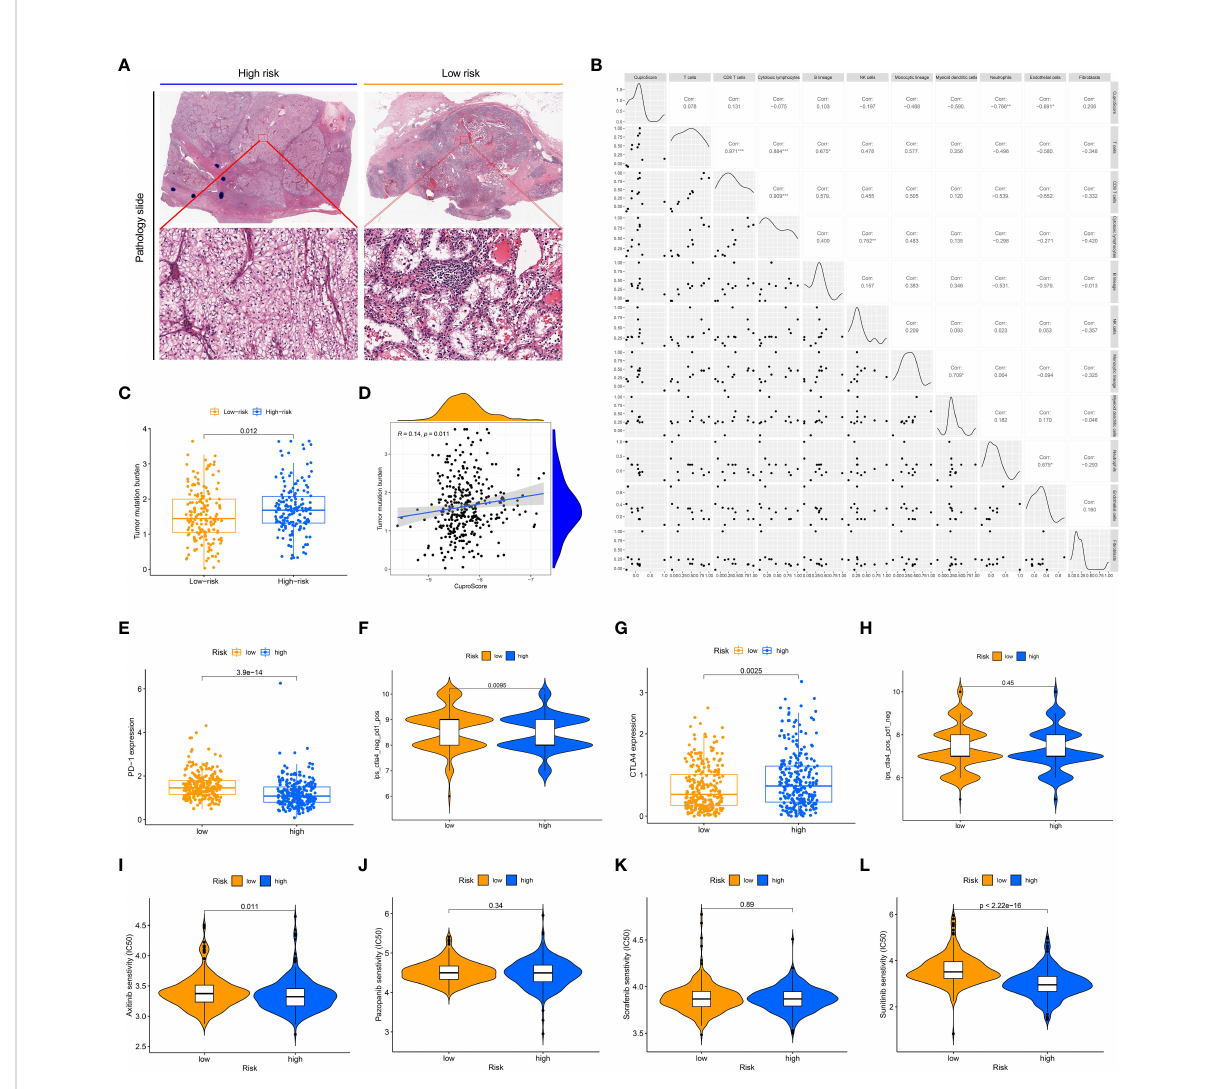
FIGURE 5 The immune landscape of the high and low CuproScore groups. (A) Representative images of the pathological HE staining of the high or low-risk group from the TCGA dataset. (B) Bubble chart of the correlation between CuproScore and immune cells. (C) Comparative tumor mutation burden in high and low-risk groups. (D) Correlation analysis of CuproScores and tumor mutation burden. Differential expression of PD-L1 (E) and relative odds of response to anti-PD-1/PD-L1 antibody (F) in high and low-risk groups. Differential expression of CTLA4 (G) and relative odds of response to CTLA4 monoclonal antibody (H) in high and low-risk groups. Drug sensitivity analysis between high and low-risk groups, including Axitinib (I) , Pazopanib (J) , Sorafenib (K) , and Sunitinib (L) . * P < 0.05, ** P < 0.01, *** P <